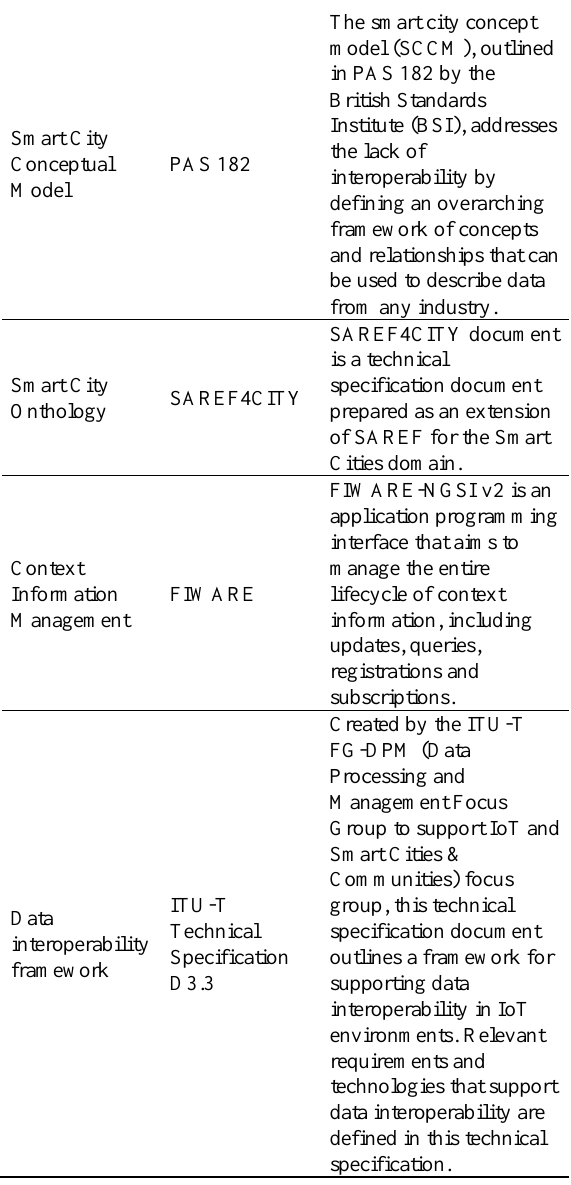
Table 1. Recommended Technologies and Standards for Semantic Interoperability in Smart